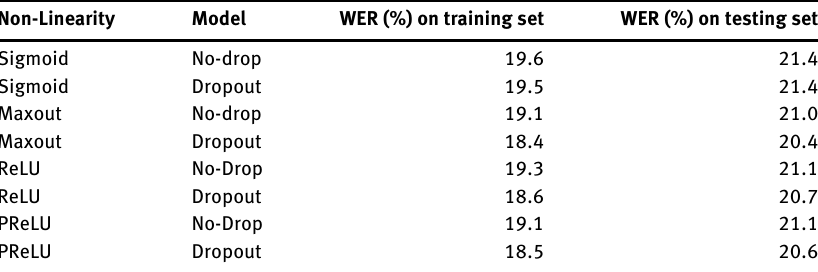
Table 7: WER as a Function of